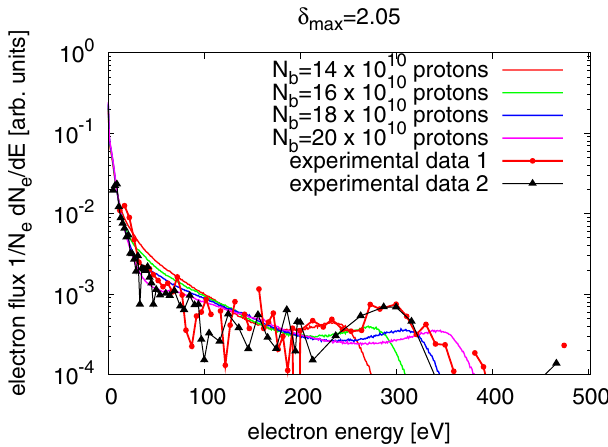
FIG. 11. (Color) Energy spectrum measured, and simulated for (cid:2) 2 : 05 and different bunch intensities. The spectrum shape (cid:10) max , but depends on the beam is not significantly affected by the (cid:10) max parameters (bunch intensity, length, etc.) [21,22].